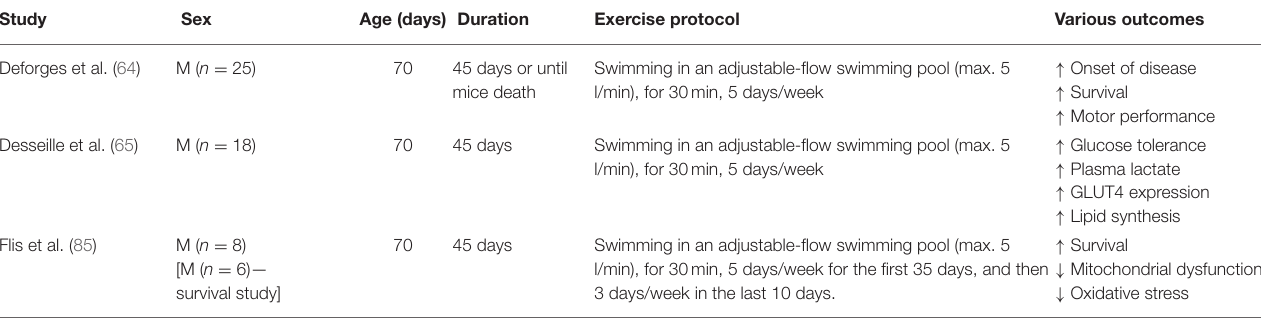
TABLE 2 | Summary of the effects of swimming-based endurance training in SOD1 G93A ALS mice.